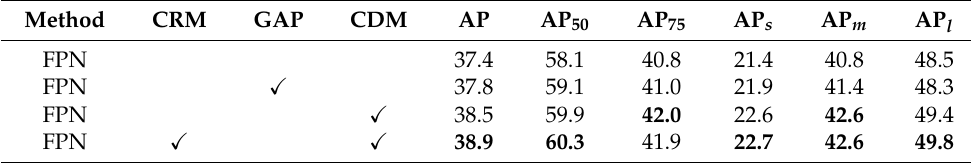
Table 2. Effects of different context operations on MS-COCO 2017 val